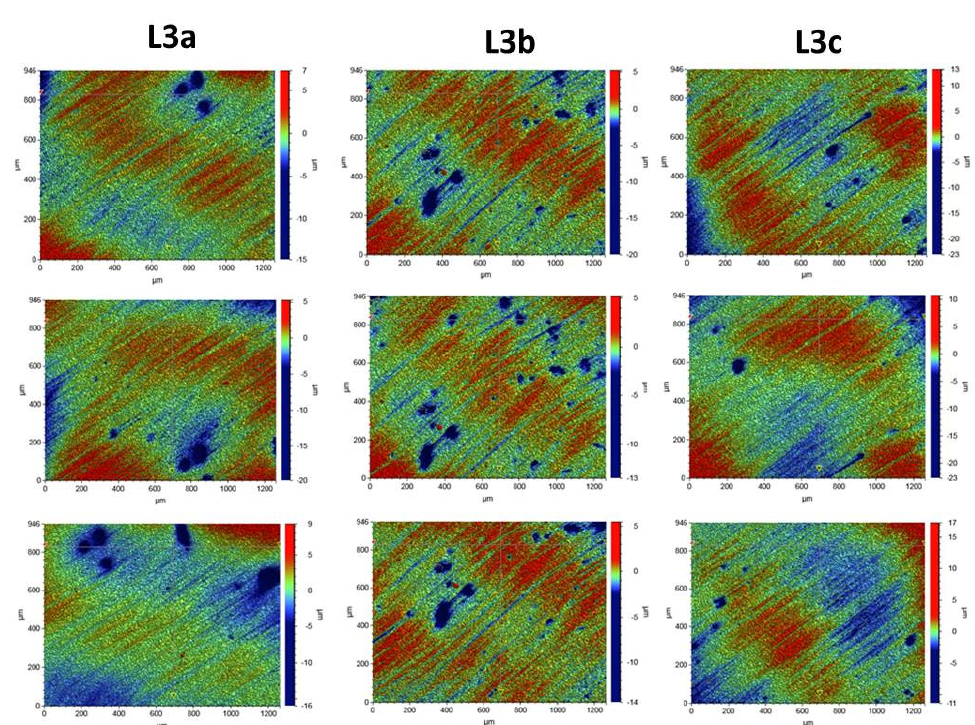
Figure 5. Surface microgeometry maps determined for the K1 composite for 3 variants of laser L3. L3a (periimplantitis variant, sweeping technique, 60 s), L3b (periimplantitis variant, sweeping technique, 2 × 30 s, with 60 s cooling break), and L3c (periimplantitis variant, scoring technique, 60 s).